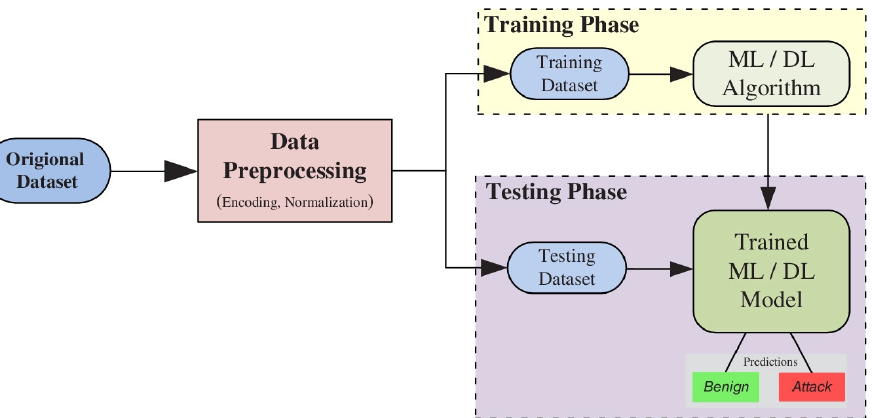
Figure 3. Methodology for generalized machine learning/deep learning-based DDoS detection